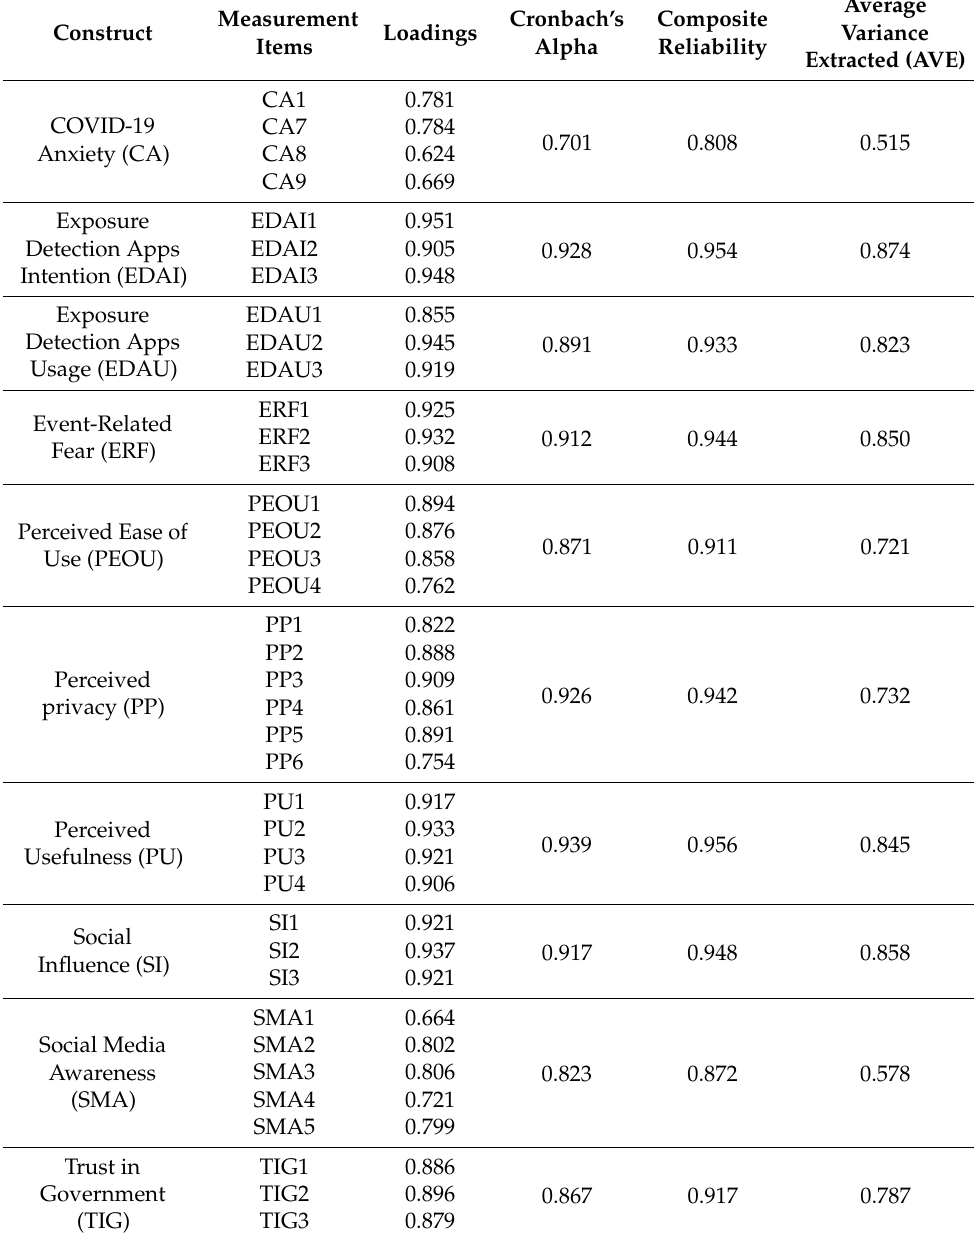
Table 2. Item loading, Cronbach’s alpha, composite reliability, average variance